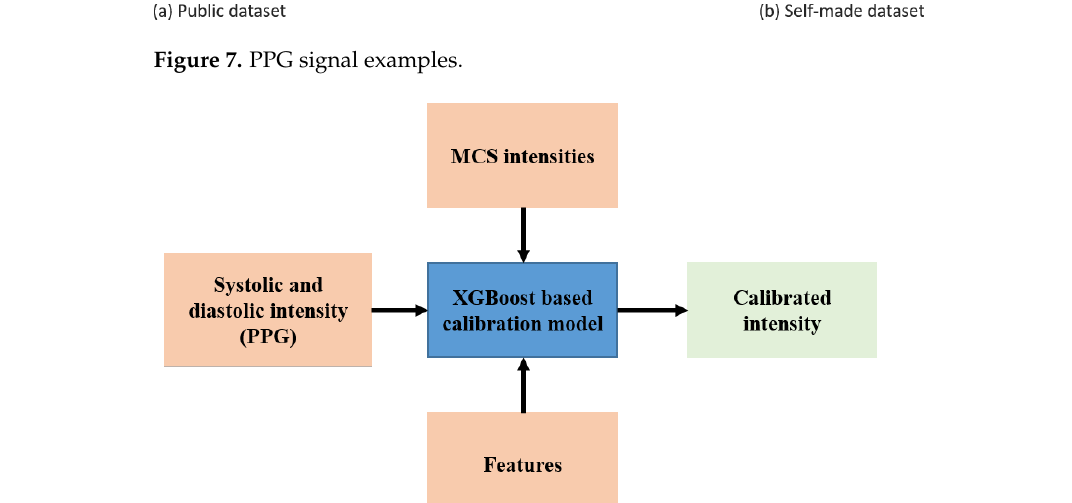
Figure 8. Workflow diagram for calibration.